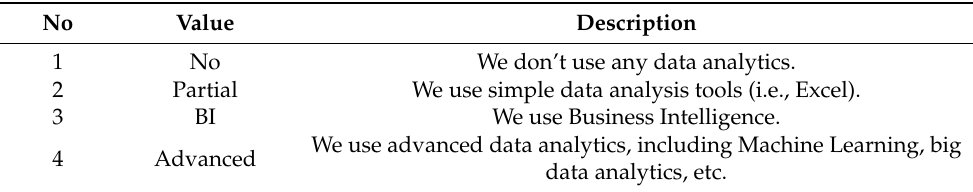
Table 1. Scales for the attribute “Data